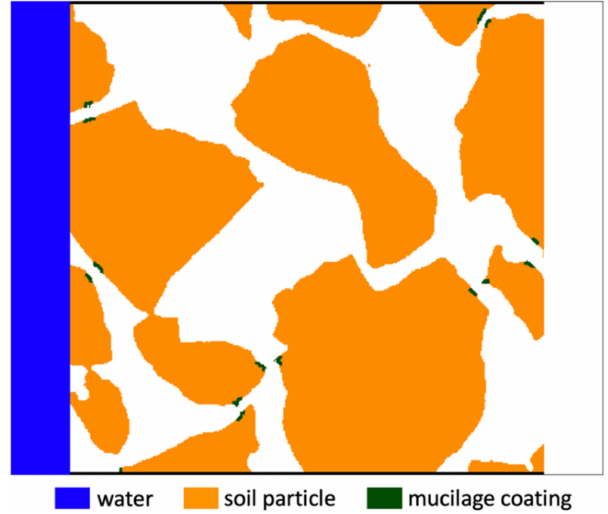
Figure 9. Sandy soil with mucilage coating (with mucilage: CA = 100 ◦ , without: CA = 20 ◦